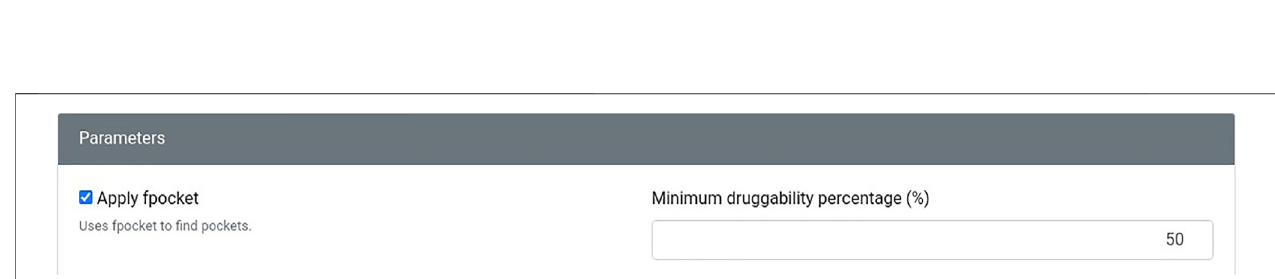
FIGURE 3 | The user can select the application of Fpocket on the exploration of pockets. In addition, if this option is activated, a minimum druggability percentage must be included.